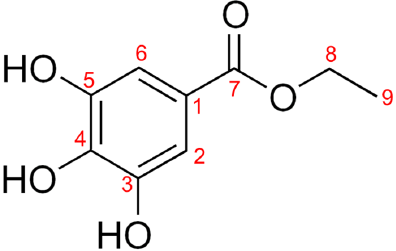
Figure 2. Chemical structure of Compound 1 (ethyl